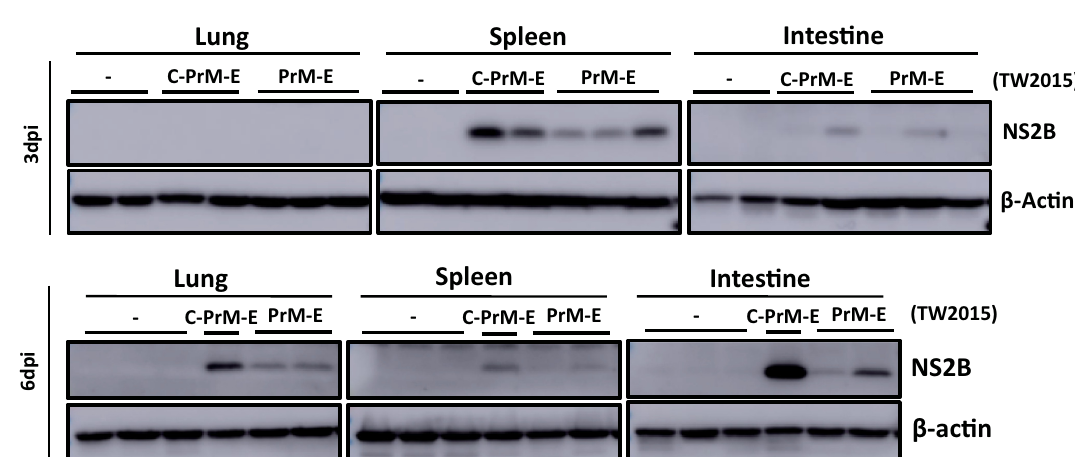
Fig 6. The TW2015 PrM-E enhanced organ dissemination. Expression of NS2B protein in tissue lysates from AGB6 mice infected with the 16681 virus, 16681/C-prM-E(2015), and 16681/prM-E(2015) mutants at 3 and 6 days post-infection